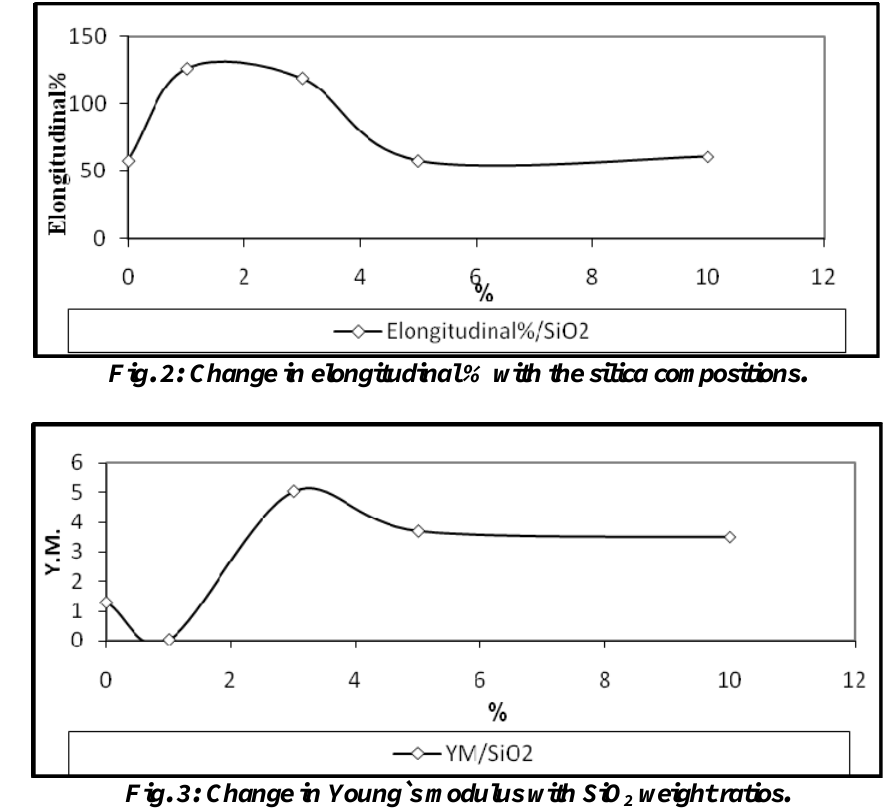
weight ratios. 2 2